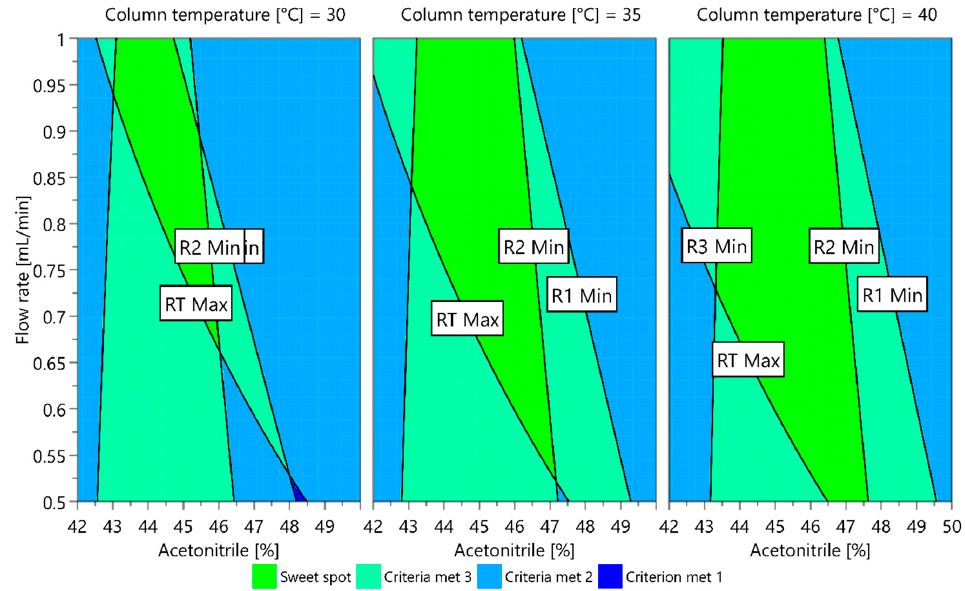
Figure 7. Sweet spot plot for a central composite design multiple linear regression (MLR) fitted model. The green area is a sweet spot where all CMA criteria are met.